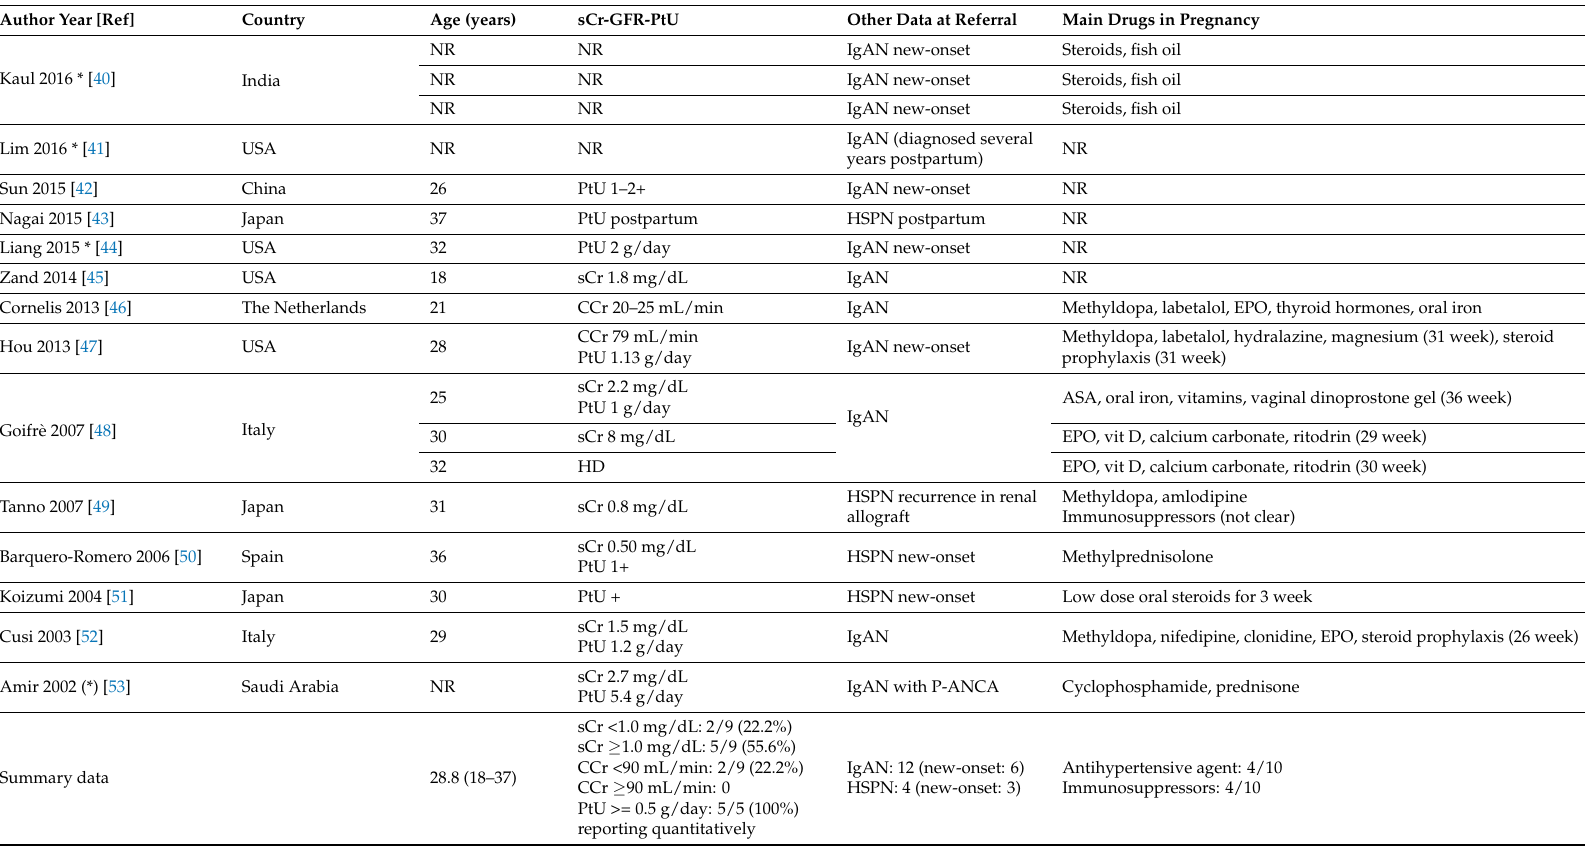
Table 5. IgA Nephropathy. Case reports: baseline